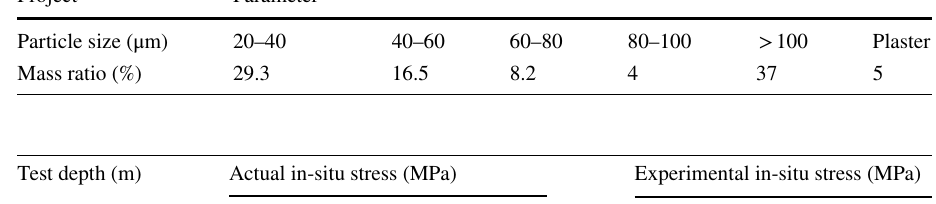
Table 2 Ratio scheme of briquettes